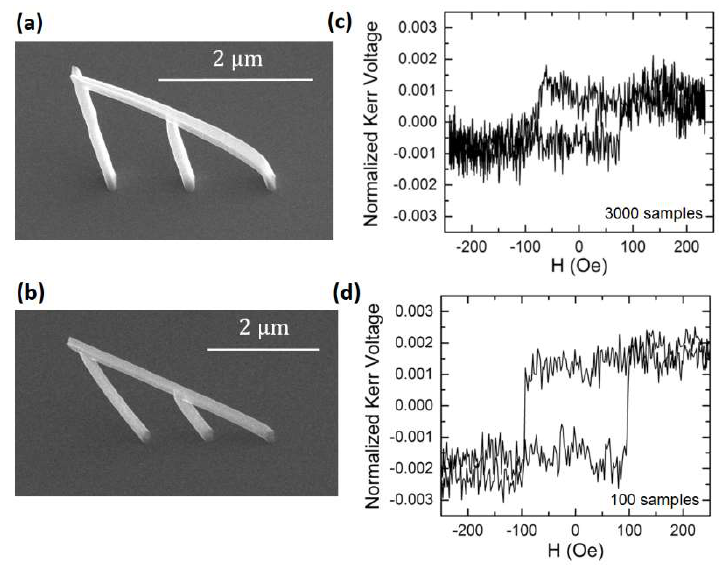
Figure 12. Detectability vs nanostructure quality. ( a ) Nanostructure showing a slight curvature along the ramp, leading to a dispersion of reflection angles; ( b ) Straight nanostructure well matched to the Dark-Field MOKE Setup; ( c ) MOKE loop obtained after 3000 averages at a field sweep rate of 23 Hz for the structure shown in ( a ); ( d ) MOKE loop obtained after 100 averages at a field sweep rate of 3 Hz for the structure shown in ( b ).